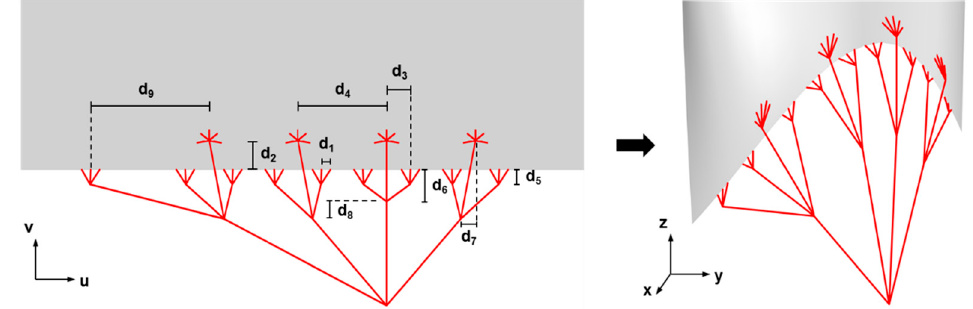
Figure 13. Chordae mapping from the 2D parametric space to the 3D topology. Figure 14. First, the TV annulus scan data from a patient was fit using a B-spline curve that generates